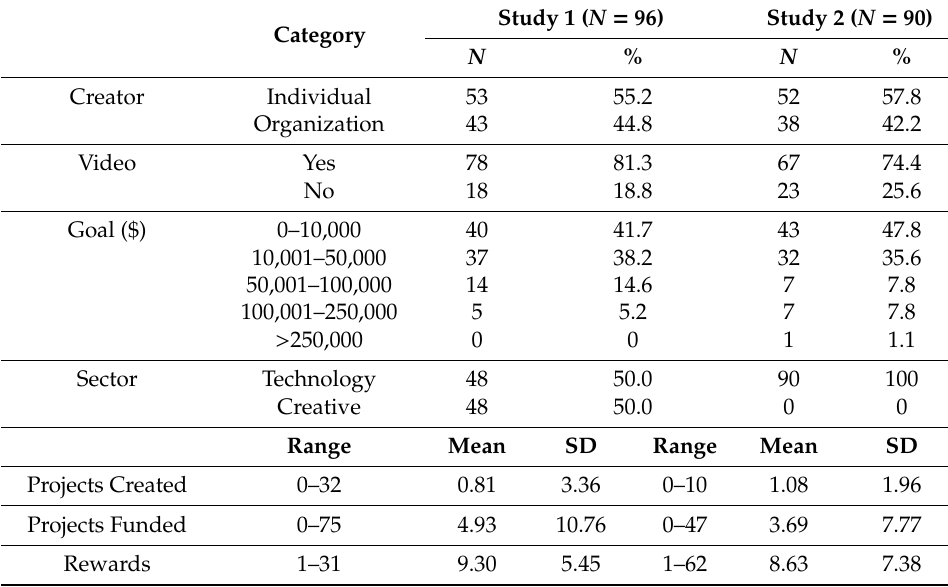
Table 1. Crowdfunding campaign